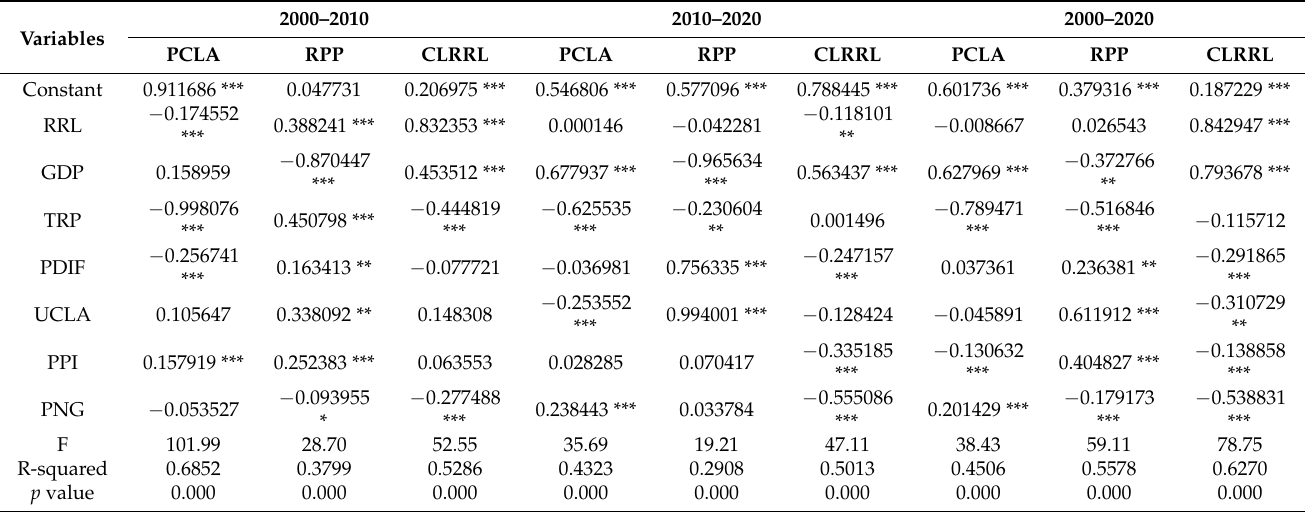
Table 7. Regression results of mediating variables.